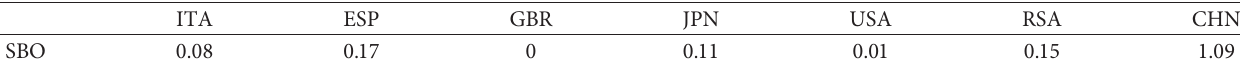
Table 3: The buffer levels of the weakening buffer operator for different countries.